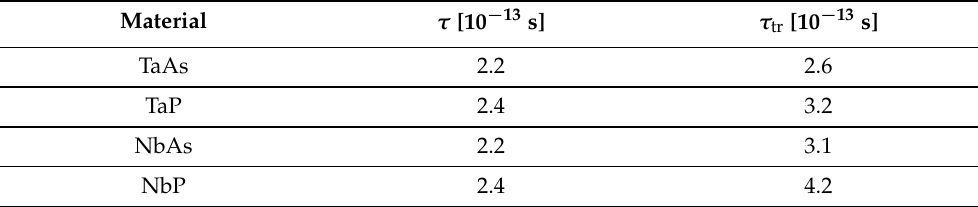
Table 3. Computed values for the total relaxation time and the total transport relaxation time for each material after Equation (50). We consider a concentration of dislocations n d = 10 11 cm − 2